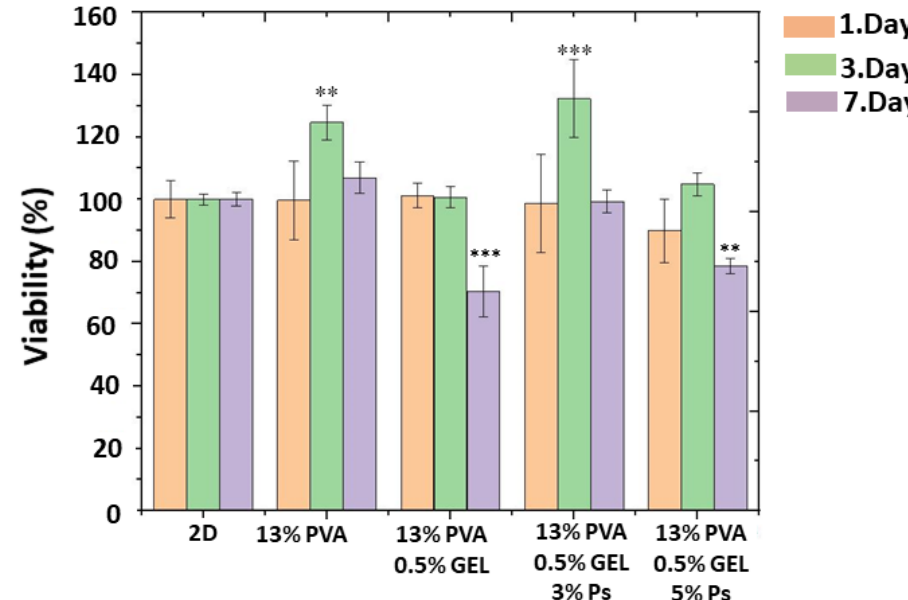
Figure 7. MTT result of the fabricated corneal nanofiber patches and 2D (MSCs) after 1, 3, and 7 days of incubation. The mark “**” points the significant difference p < 0.01 and the mark “***” represents the significant difference p < 0.001.